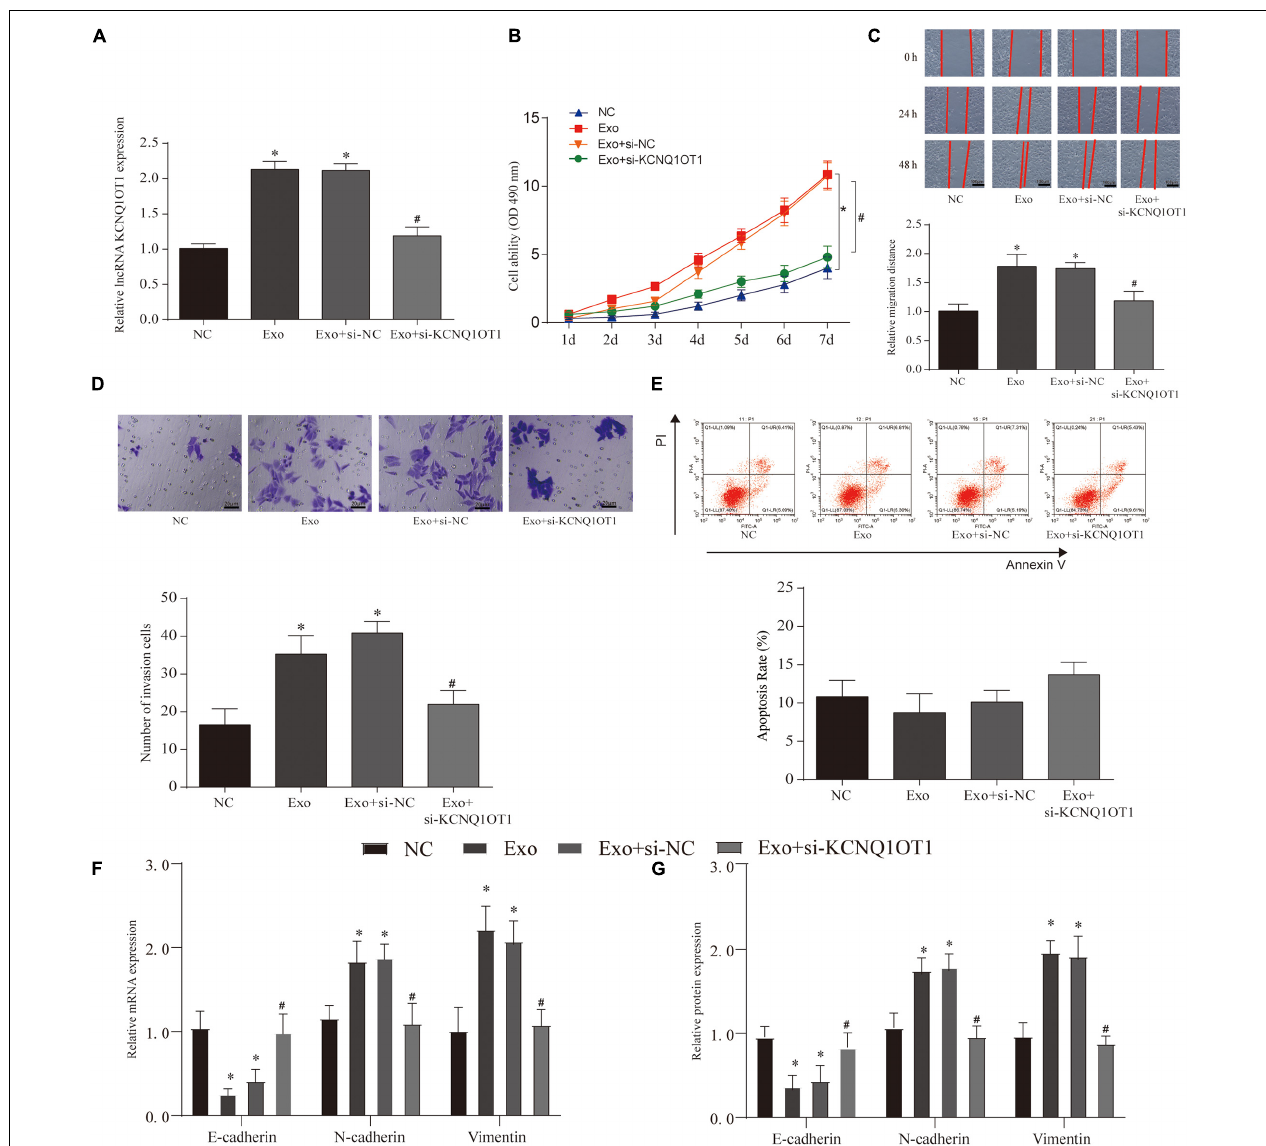
FIGURE 3 | Colorectal cancer (CRC)-derived exosomes promote the proliferation and invasion of CRC in the in vitro assay. (A) KCNQ1OT1 expression in different treatment groups. (B) Cell Counting Kit (CCK)-8 is used to analyze the proliferation ability of CRC cells after different treatments. (C,D) Wound healing and Transwell assay were used to detect the migration and invasion ability of CRC cells after different treatments. (E) Detection of CRC cell apoptosis in different treatment groups. (F,G) Expression of epithelial–mesenchymal transition (EMT)-related genes and proteins. ∗ p < 0.05 compared with the NC group, # p < 0.05 compared with the Exo+si-NC